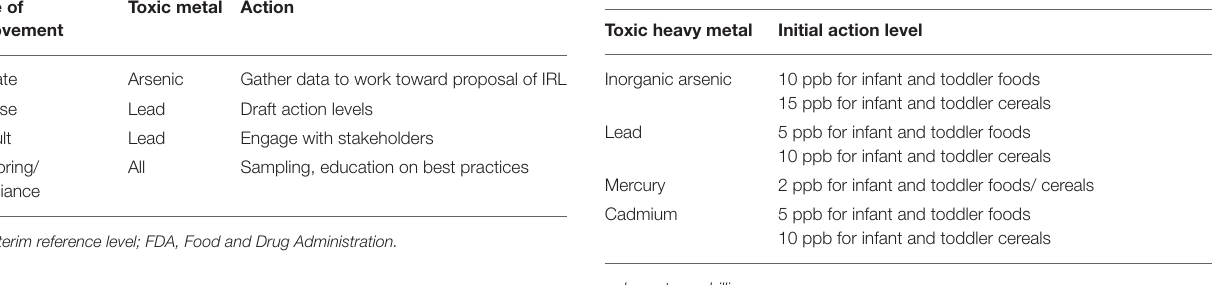
TABLE 9 | Recommended initial action levels from the Baby Food Safety Act (H.R. 2229).